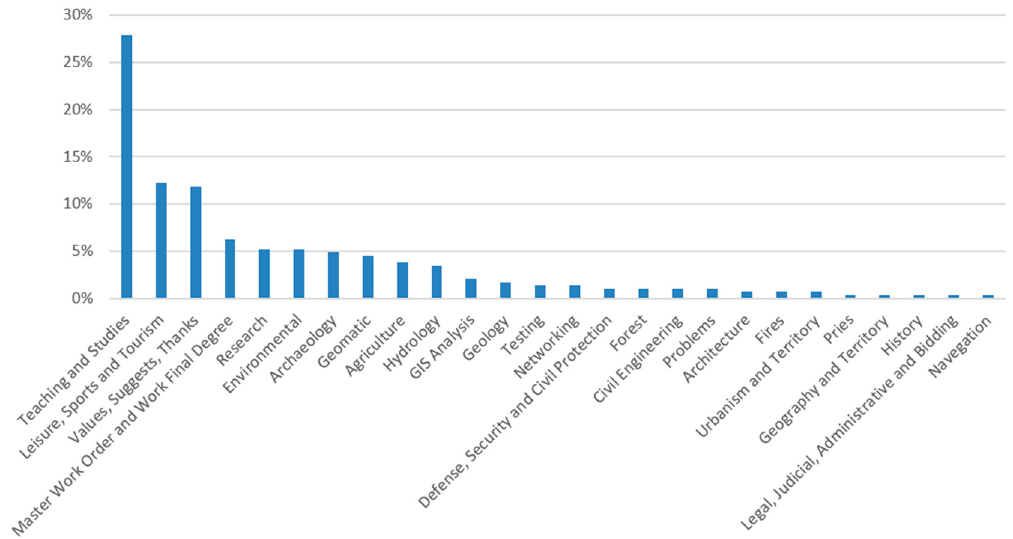
Figure 8. Percentage of responses normalized to total considered responses (287).